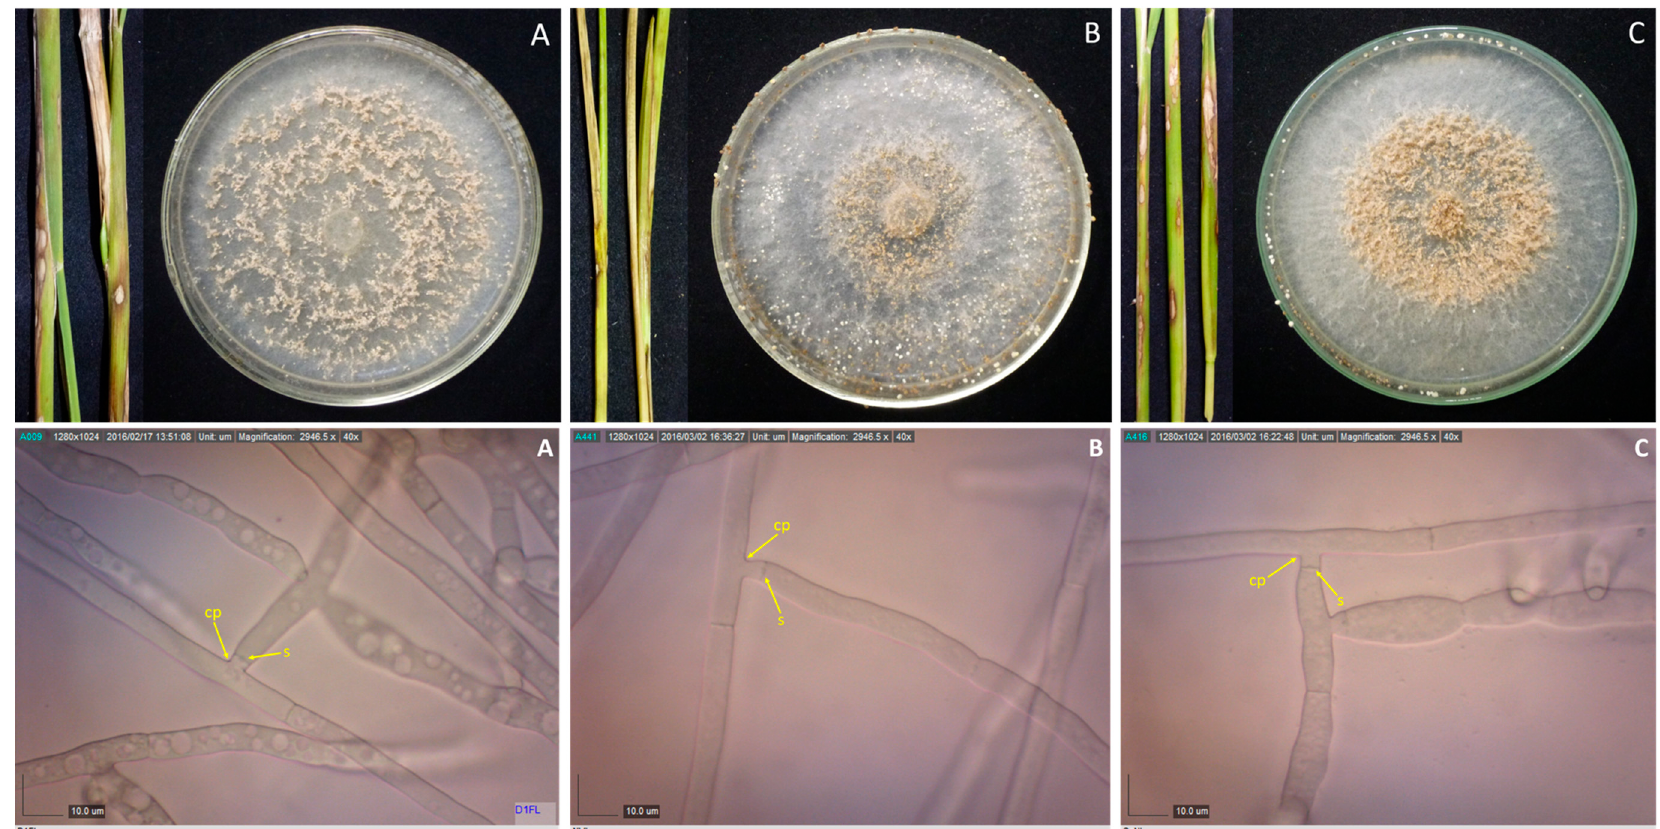
Figure 2. Rice stems showing sheath blight symptoms, and 10-day-old cultures of their corresponding pathogens, as well as their photomicrographs showing the mycelia branching at an acute to right angle with slight constriction at the point (cp) of branching and septum (s) formed near the branching point for isolates D1FL ( A ), NVL ( B ), and ScNL ( C ). Samples were viewed at 40×.